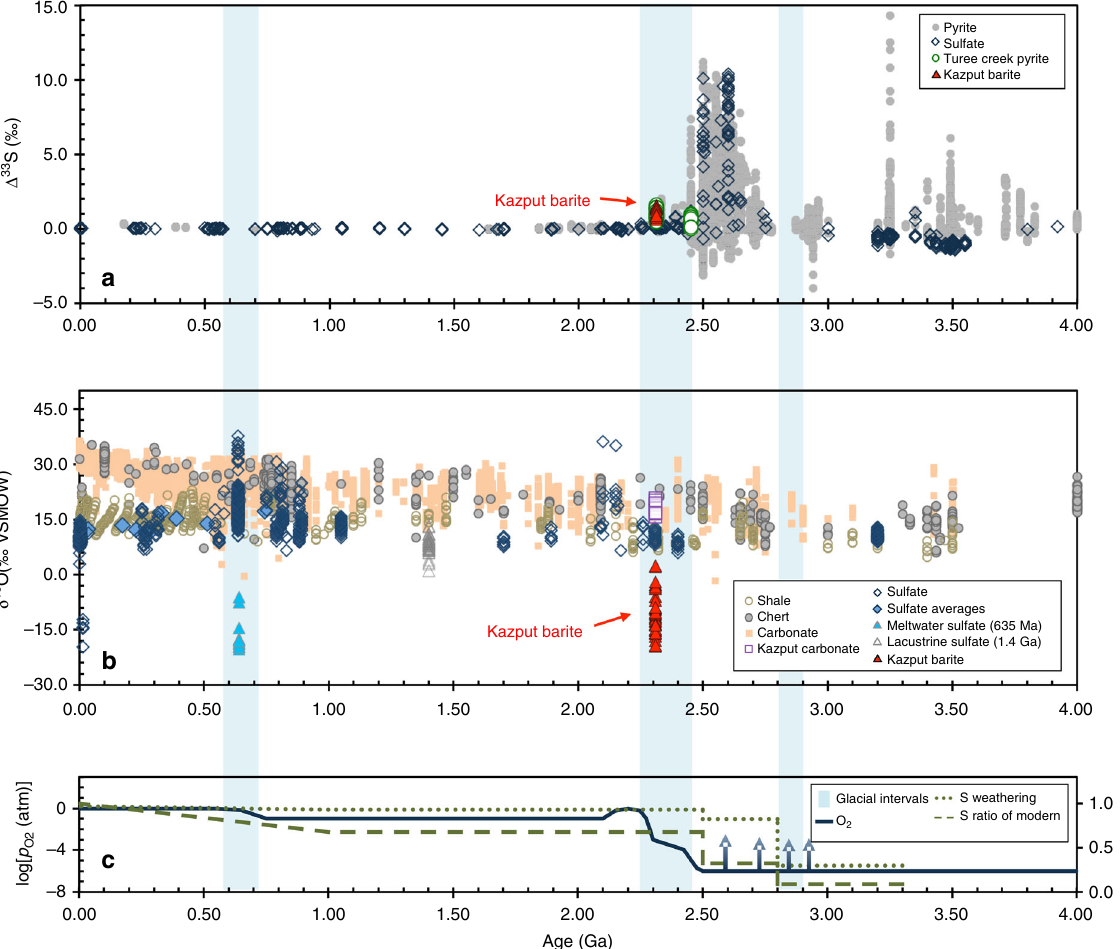
Fig. 1 Kazput Formation barite sulfur and oxygen isotope data from this study are shown alongside compilations of time series data and temporal estimates of sulfur fl uxes and atmospheric O 2 . In further detail, shown are a pyrite and sulfate Δ 33 S data, b δ 18 O data of sedimentary carbonate, chert, shale, and sulfate and c the evolution of O 2 showing maximum ranges 67 with ratios of sulfur in fl uxes to the ocean of total versus present day and weathering versus total fl ux 61 . The shaded regions represent intervals of glaciations of possibly global signi fi cance. The Turee Creek pyrite data in a are from 16 , and Kazput carbonate data in b are from 33 . Data sources and details are provided in Supplementary Note 1, while source data are provided in a Source Data fi